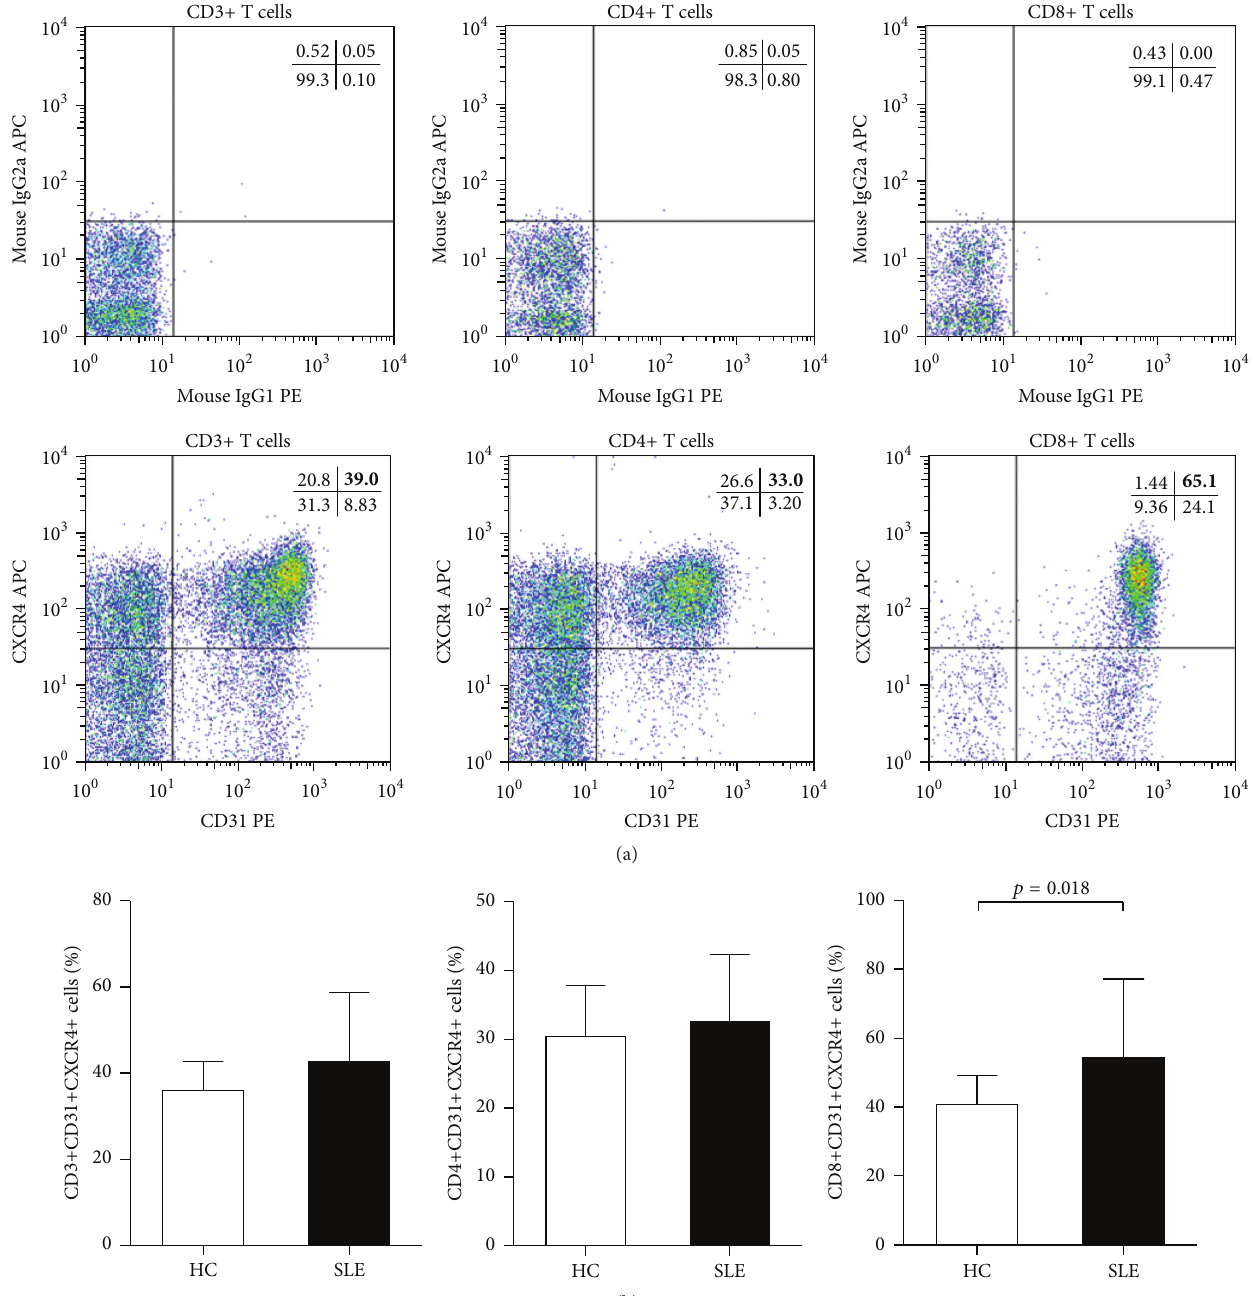
Figure1:FACSanalysisofcirculatingTangcellsubsets.(a)TypicalexamplesofCD31andCXCR4expressionaftergatingonCD3+,CD4+,and CD8+ T cells from peripheral blood of representative patients with SLE. Quadrants were set according to the fluorescence signal provided by the isotype-matched control IgG antibodies. (b) Percentages of circulating Tang cell subsets (including CD31+CXCR4+ cells in CD3+, CD4+, and CD8+ T cells) in SLE patients and HC are shown. 𝑝 values were assessed by Mann-Whitney U test.